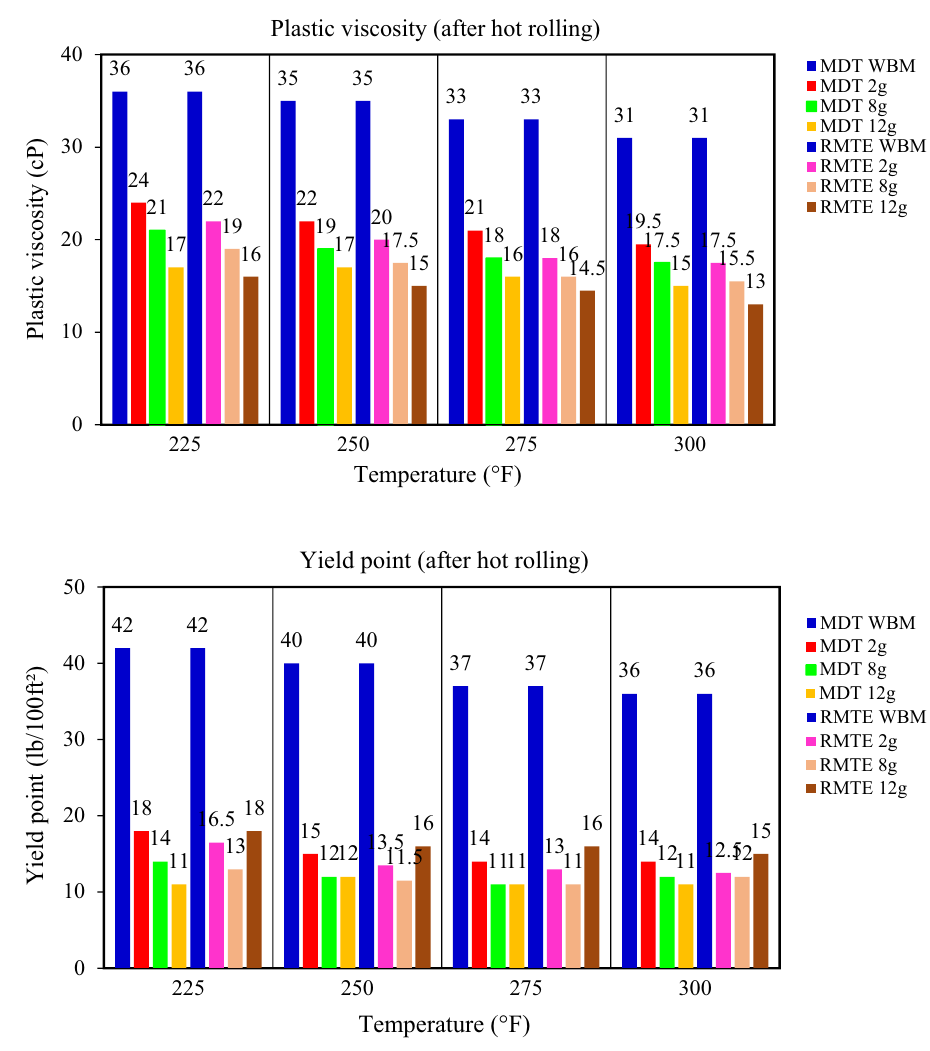
Fig. 11 Effect of temperature on plastic viscosity of MDT and RMTE mud samples